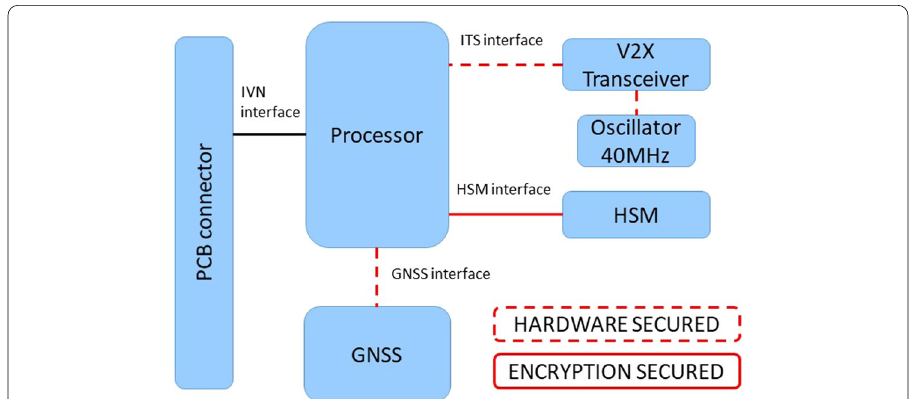
Fig. 4 Schematics of hardware securization interfaces in OBU